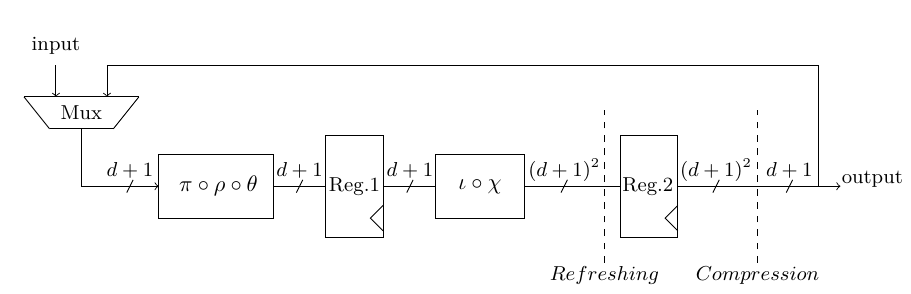
Figure 3: Round function of the original DOM-Keccak with two register